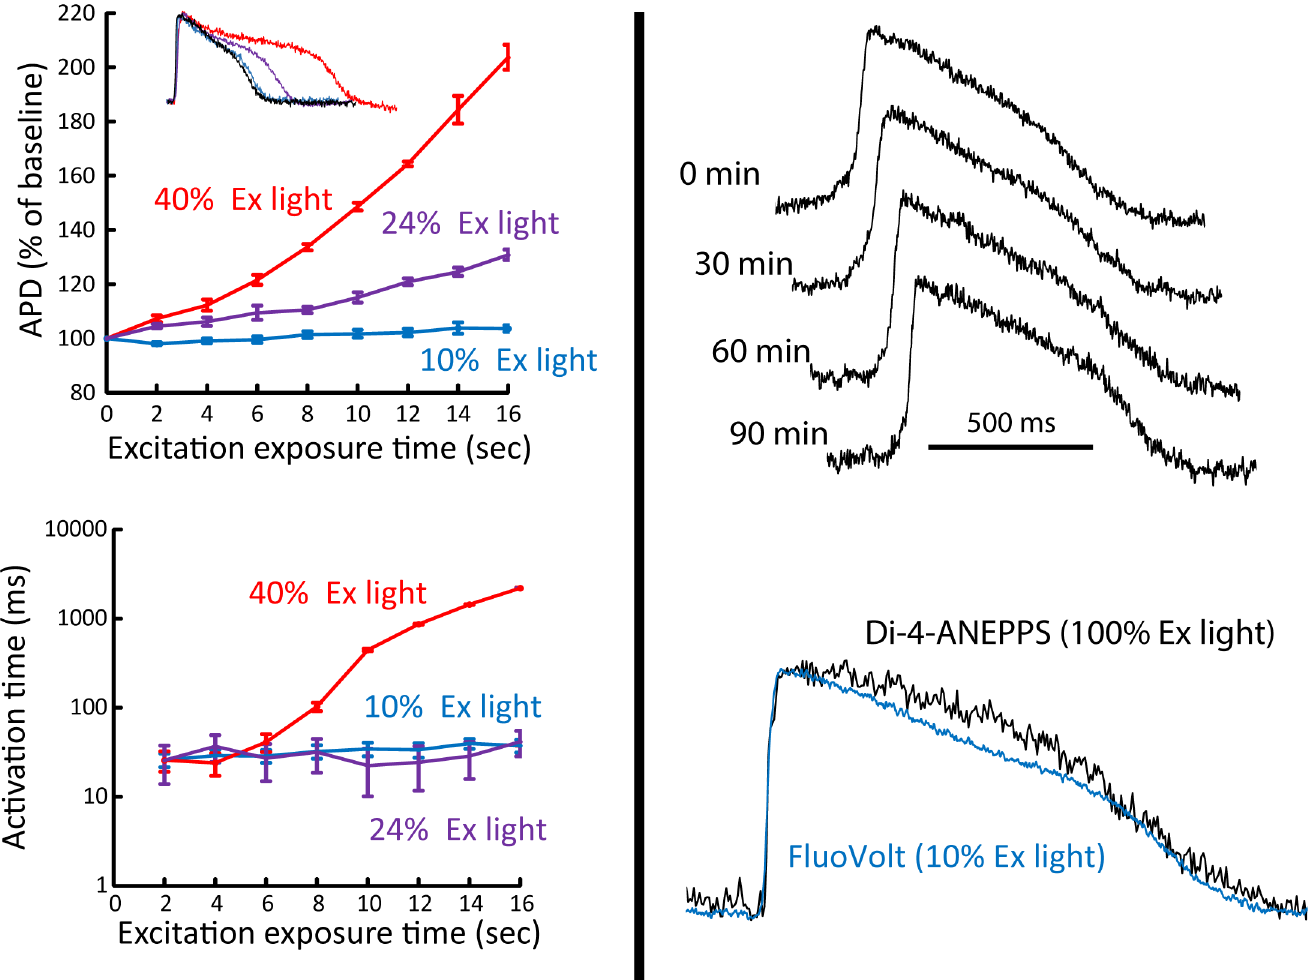
Fig 5. Effect of FluoVolt on electrical activity. Left panel shows phototoxiceffects of FluoVolt when using various excitationintensities. Top shows that at 40% (178 mW/cm 2 , red) and 24% (109 mW/cm 2 , purple) of maximum excitationlight, significantprolongation of APD is observed over 20 seconds of continuous excitation. In contrast, at 10% (50 mW/cm 2 , blue) of maximum, no APD changesare observed. Action potentialrecordings(inset) from separatewells at each light level including baseline(black, first action potentialrecorded)show that signalquality is preserved. The left bottom graph shows the phototoxiceffect on depolarization, as quantifiedby activationtime delay (time from a fiducialpoint to maximum dVm/dt of each consecutive action potential).Only 40% excitationlight had an effect on depolarization time as indicatedby a delay in activationtime by about 2000 ms. Right panel (top) shows the effect of FluoVolt washout on the action potentialover a 90 minute time period, and the superiorsignal fidelity of FluoVolt comparedto di- 4-ANEPPS averagedfrom the same number of pixels (bottom).